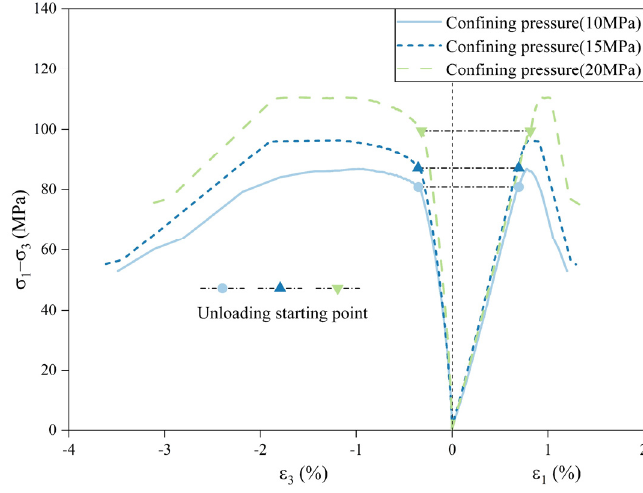
Figure 4. Triaxial unloading test stress-strain curve.